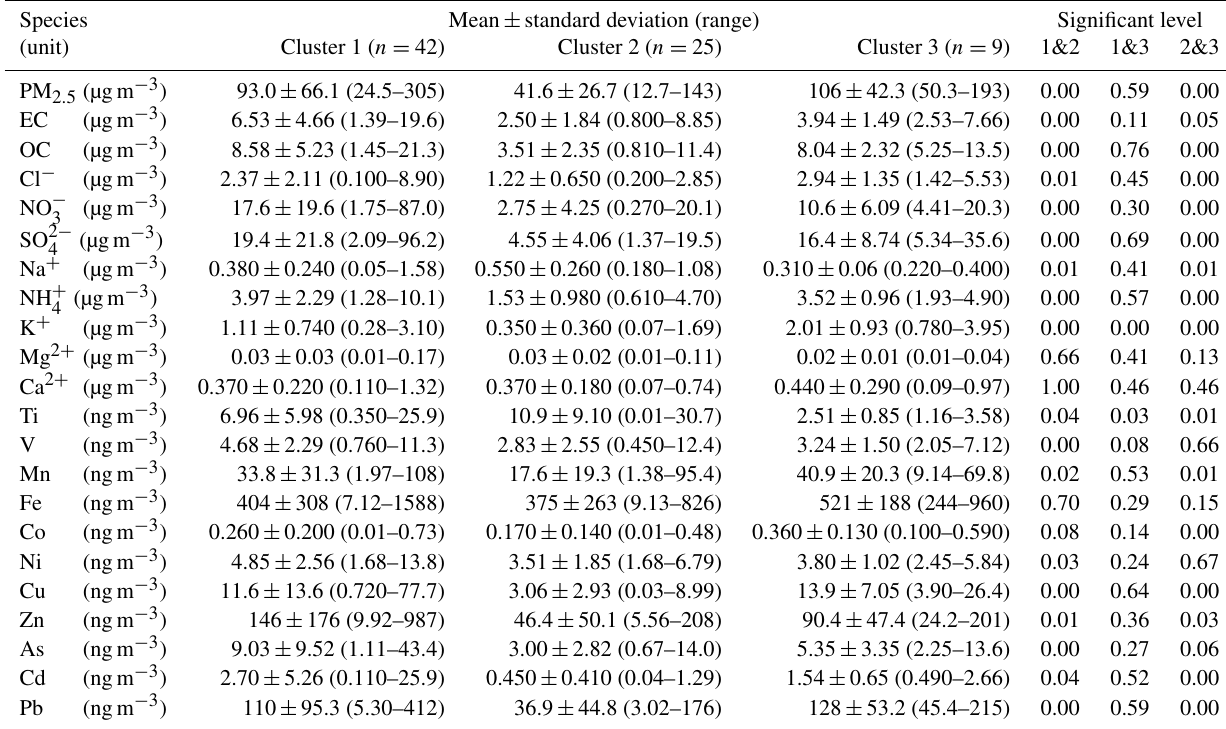
Table 1. Statistics of PM 2 . 5 chemical species in different clusters and significant level by mean test. Species Mean ± standard deviation (range) Significant